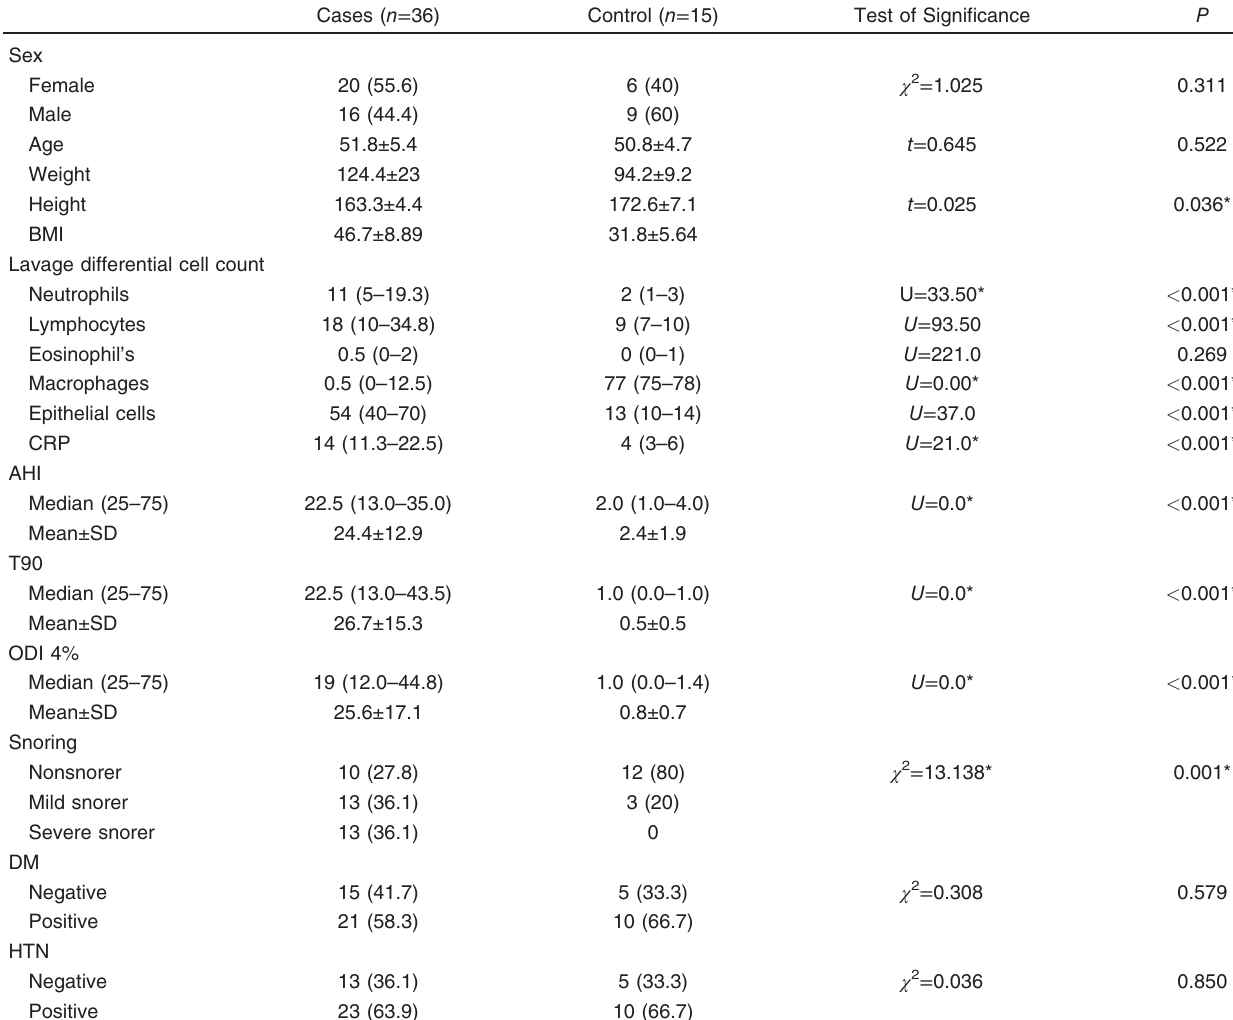
Table 1 Comparison between the two studied groups according to different parameters Cases ( n =